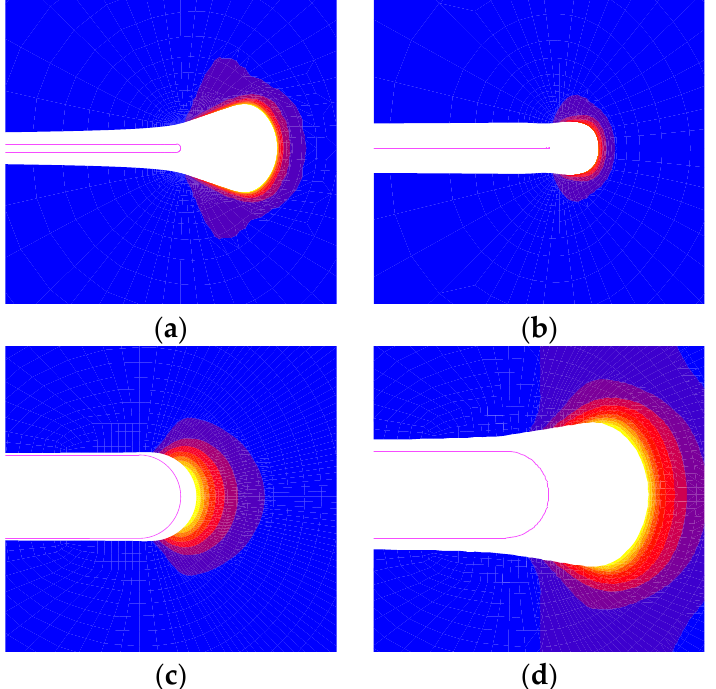
Figure 4. Initial and deformed crack tips after applying 20 cycles (with the cumulative equivalent plastic strain in color) for the totally straight crack: ( a ) b 0 = 5 μ m, Δ K = 50 MPam 1/2 ; ( b ) b 0 = 0.5 μ m, Δ K = 50 MPam 1/2 ; ( c ) b 0 = 50 μ m, Δ K = 25 MPam 1/2 ; and ( d ) b 0 = 50 μ m, Δ K = 50 MPam 1/2 .